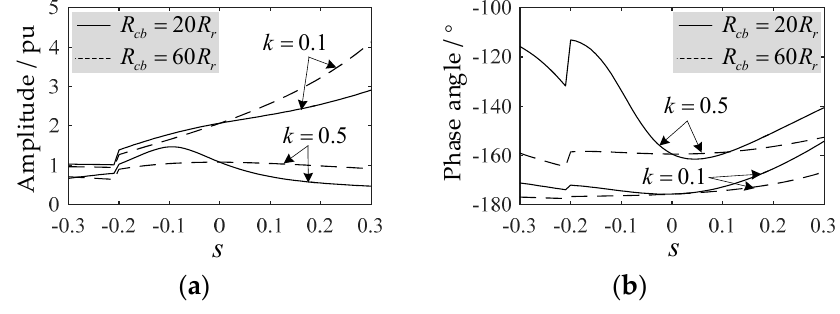
 Z : ( a ) amplitude; and ( b ) phase angle. : ( a ) amplitude; and ( b ) phase angle. w ∞ + w 